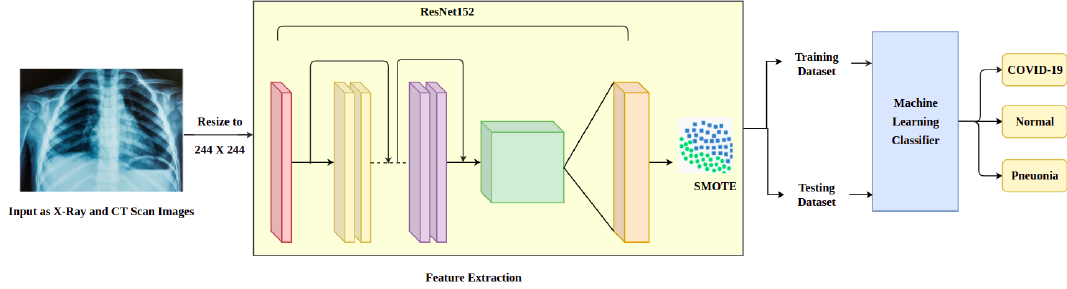
Figure 1. Architecture of the proposed system with a sample scenario of Resnet